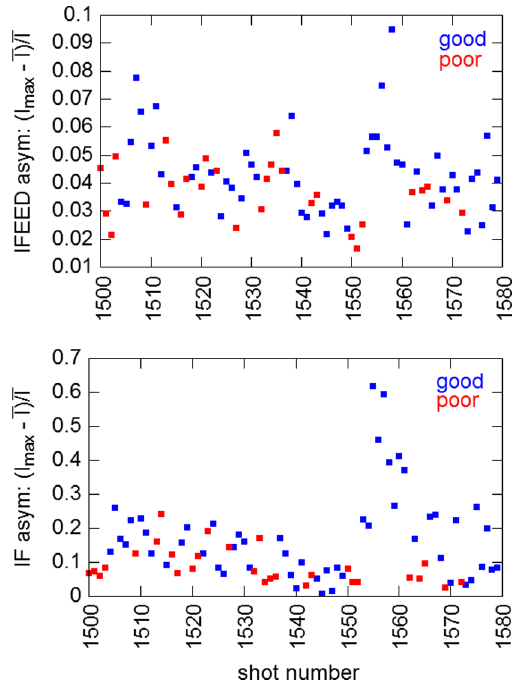
FIG. 12. The azimuthal asymmetry of the IFEED (top) and IF (bottom) currents versus shot number. The asymmetry is the difference between the highest probe value and the average, − ¯ I Þ = ¯ I . Good shots are shown in normalized by the average, ð I max blue and poor shots in